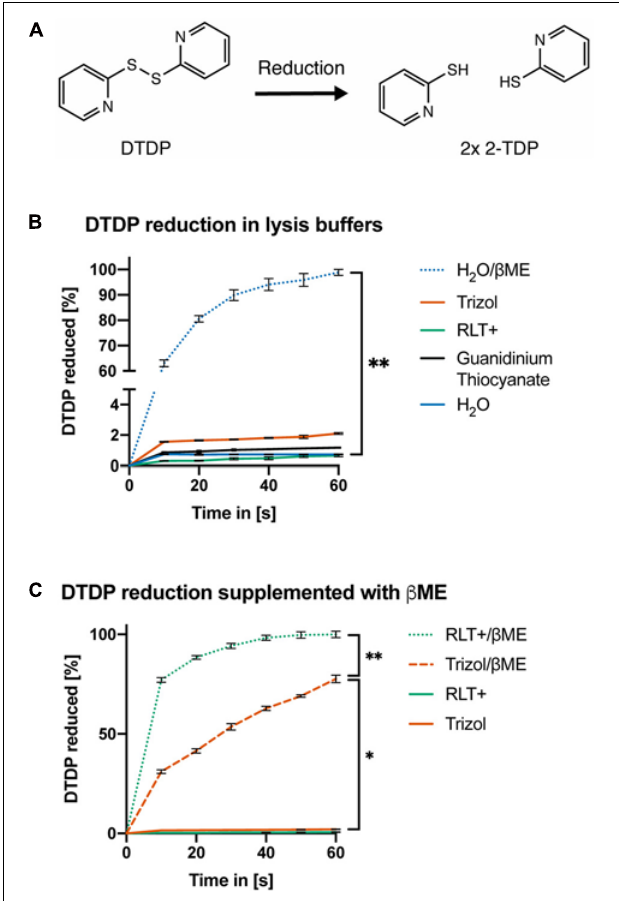
FIGURE 3 | DTDP assay reveals pH-dependent activity of reducing agents. (A) Reduction of 2,2 (cid:48) -Dithiodipyridine (DTDP) produces 2-thiopyridione (2-TPD). (B,C) Measurement of DTDP reduction in % during 60 s. (B) DTDP is not reduced by Trizol, Buffer RLT+, 1 M guanidinium thiocyanate or water. Water supplemented with 50 mM β ME reduces DTDP within 60 s. (C) Buffer RLT+ supplemented with β ME completely reduces DTDP. Trizol supplemented with β ME reduces 75% of DTDP in the same time. Each condition was repeated 3 times ( n = 3). Data are represented as mean ± standard error of mean (SEM). Significant ANOVAs were followed by Tukey’s post hoc test, * p < 0.05, ** p < 0.01.